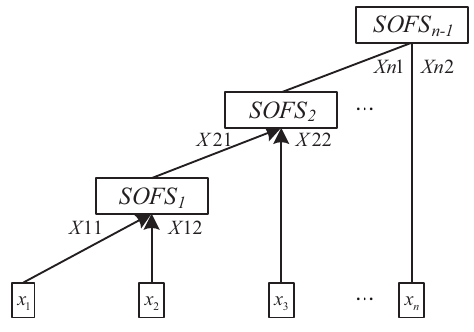
Figure 1. The structure of the